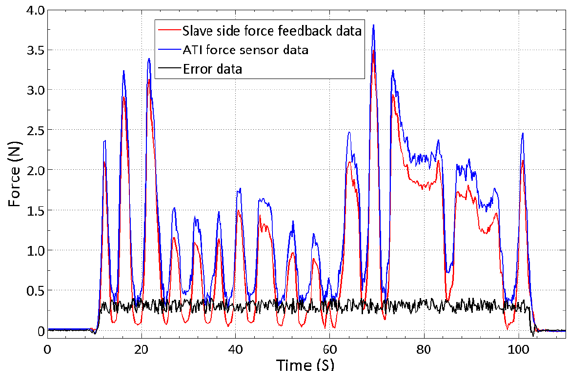
Figure 10. Results of the time-varying force measurement.